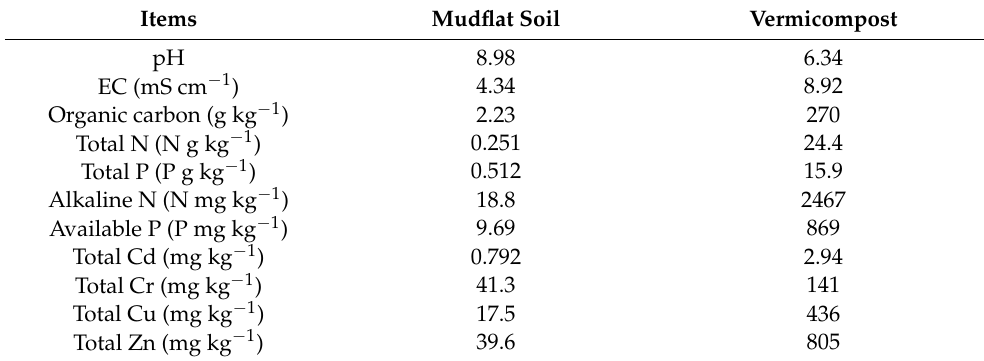
Table 1. Basic properties of the mudflat soil and vermicompost used in this study.